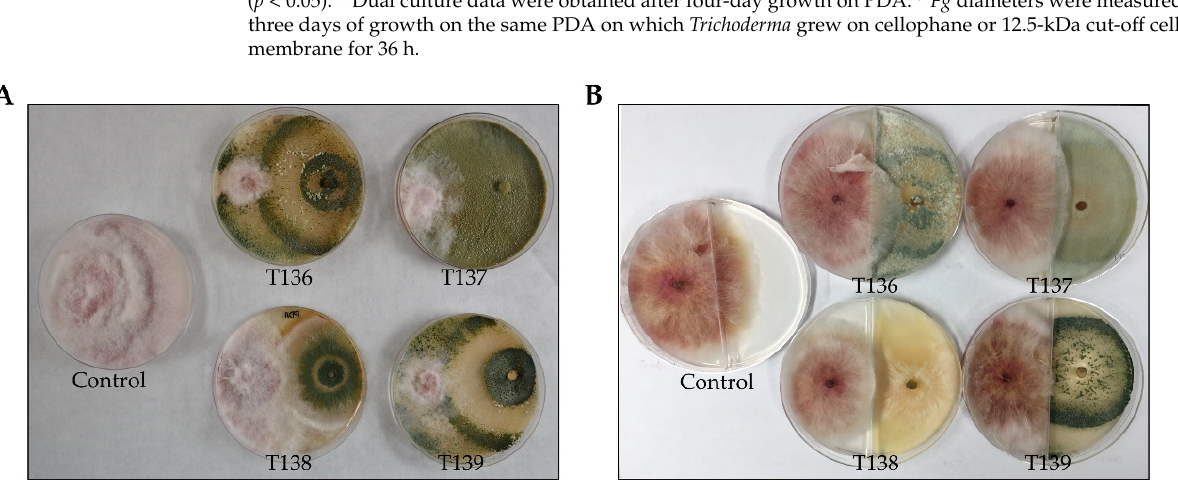
Table 3. Protease, cellulase, and chitinase activities that were measured for four Trichoderma strains ( T. harzianum T136, T. simmonsii T137, T. afroharzianum T138, and T. harzianum T139) in extracellular